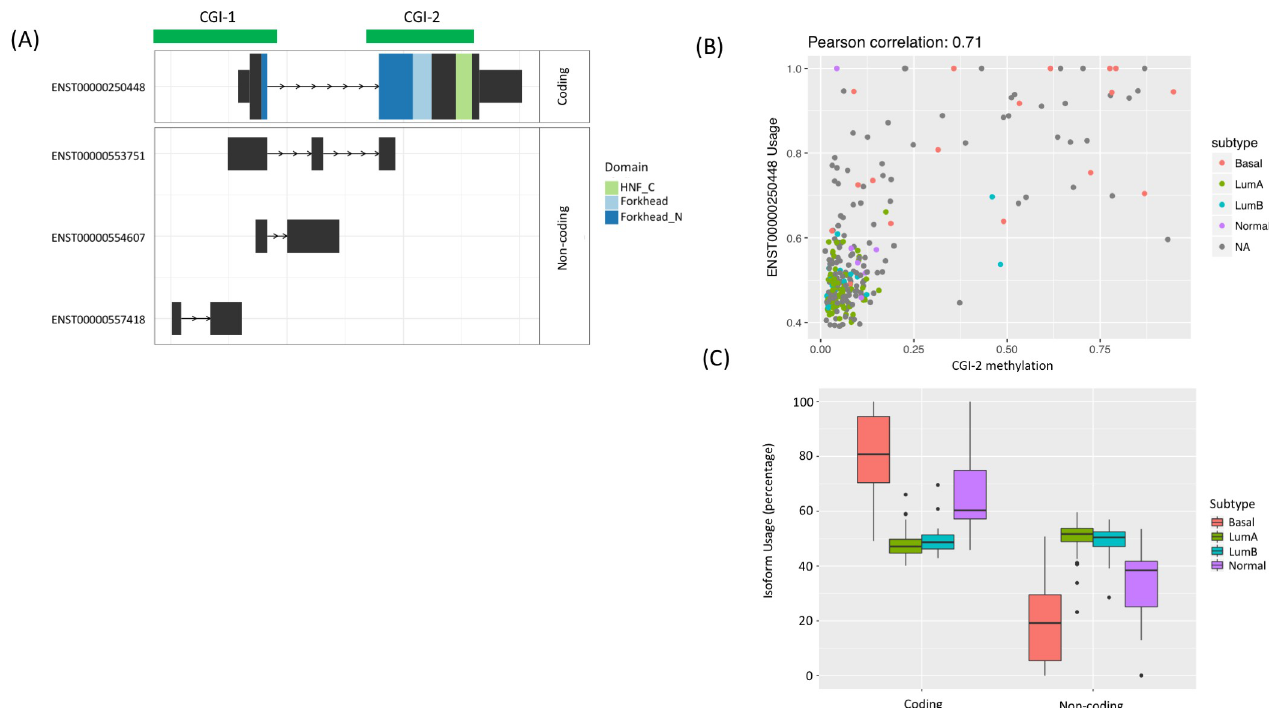
Fig 5. In breast cancer samples, DNAm at FOXA1 is correlated with subtype-linked switching from coding to non-coding isoforms. (A) A schematic plot of the FOXA1 locus shows two CpG islands (CGIs), a coding isoform ( top , with functional domains labeled), and three non-coding isoforms (bottom ). CGIs shown in dark green. (B) Across the breast cancer subtypes and normal samples, DNAm in CGI-2 of the coding FOXA1 isoform (ENST00000250448) was positively correlated with differential (coding) isoform usage. (C) Box plots indicate significant differences (P < 0.05; Wilcoxon rank sum test) in usage of the FOXA1 coding isoform and non-coding isoforms between basal vs luminal A and B samples, and between basal subtype and normal samples.